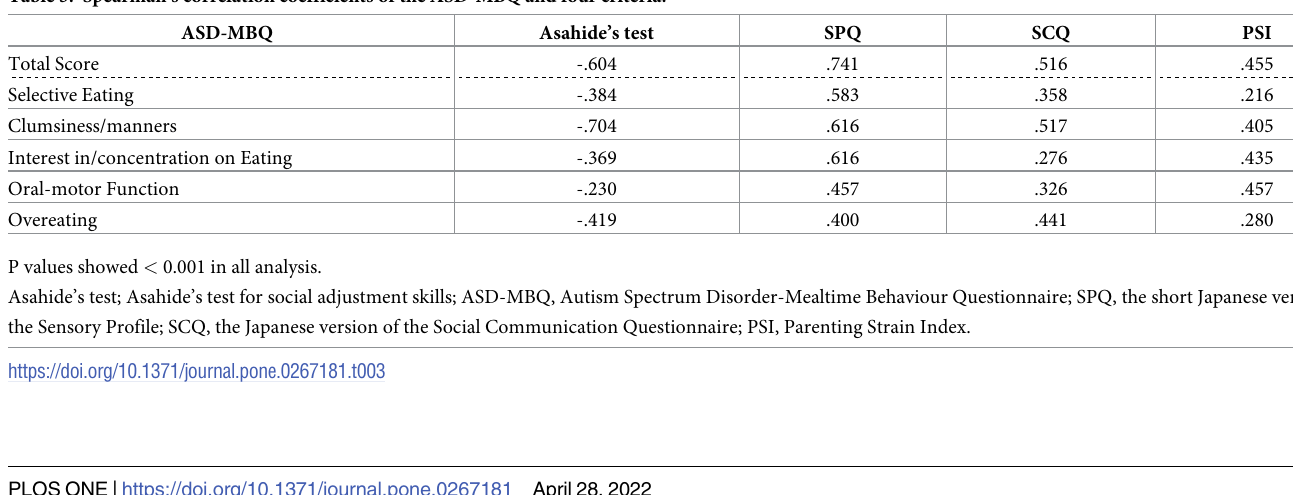
graphic data. Age range of participants in this study is presented as S1 Table.